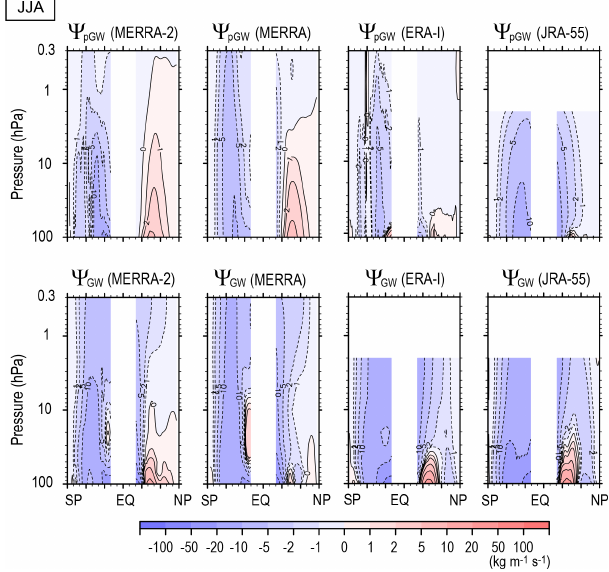
Figure 13. Meridional cross sections of the climatology of the an- nual mean stream function due to parameterized GWs (upper pan- els) and potential GW contributions (lower panels) for MERRA-2, MERRA, ERA-Interim and JRA-55 (from left to right).